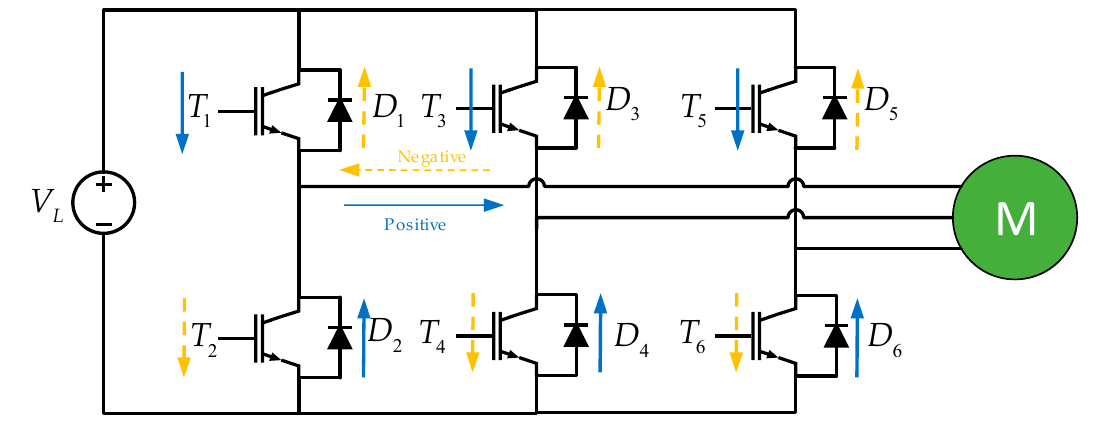
Figure 1. Topological structure of three-phase voltage source